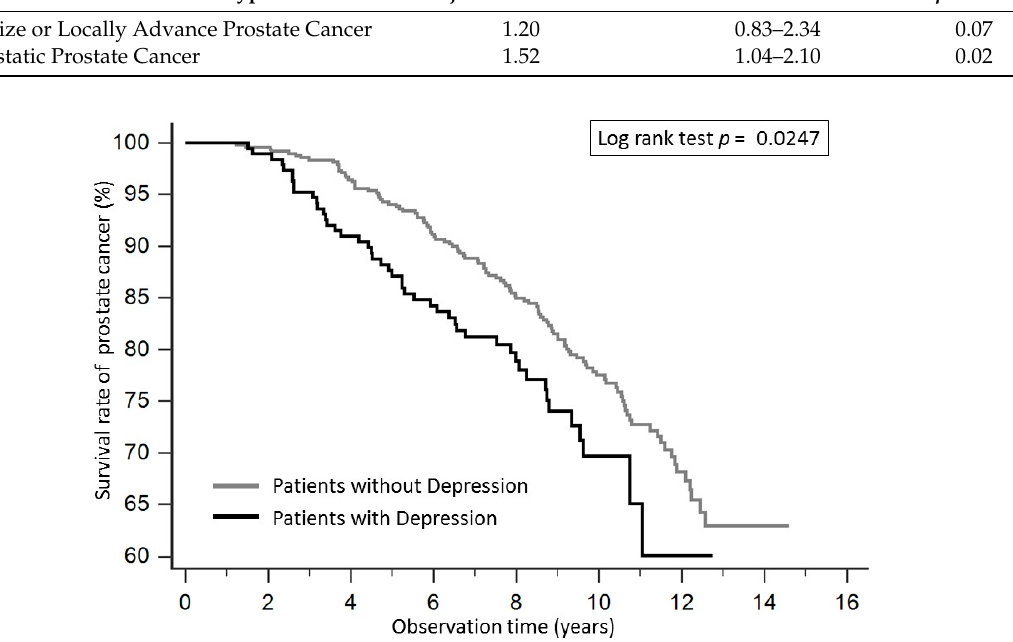
Figure 2. The Kaplan-Meier survival curve for patients with prostate cancer according to depression. The survival rate in patients with depression was significantly lower compared to those without depression, and the p value of the log-rank test was 0.0247.